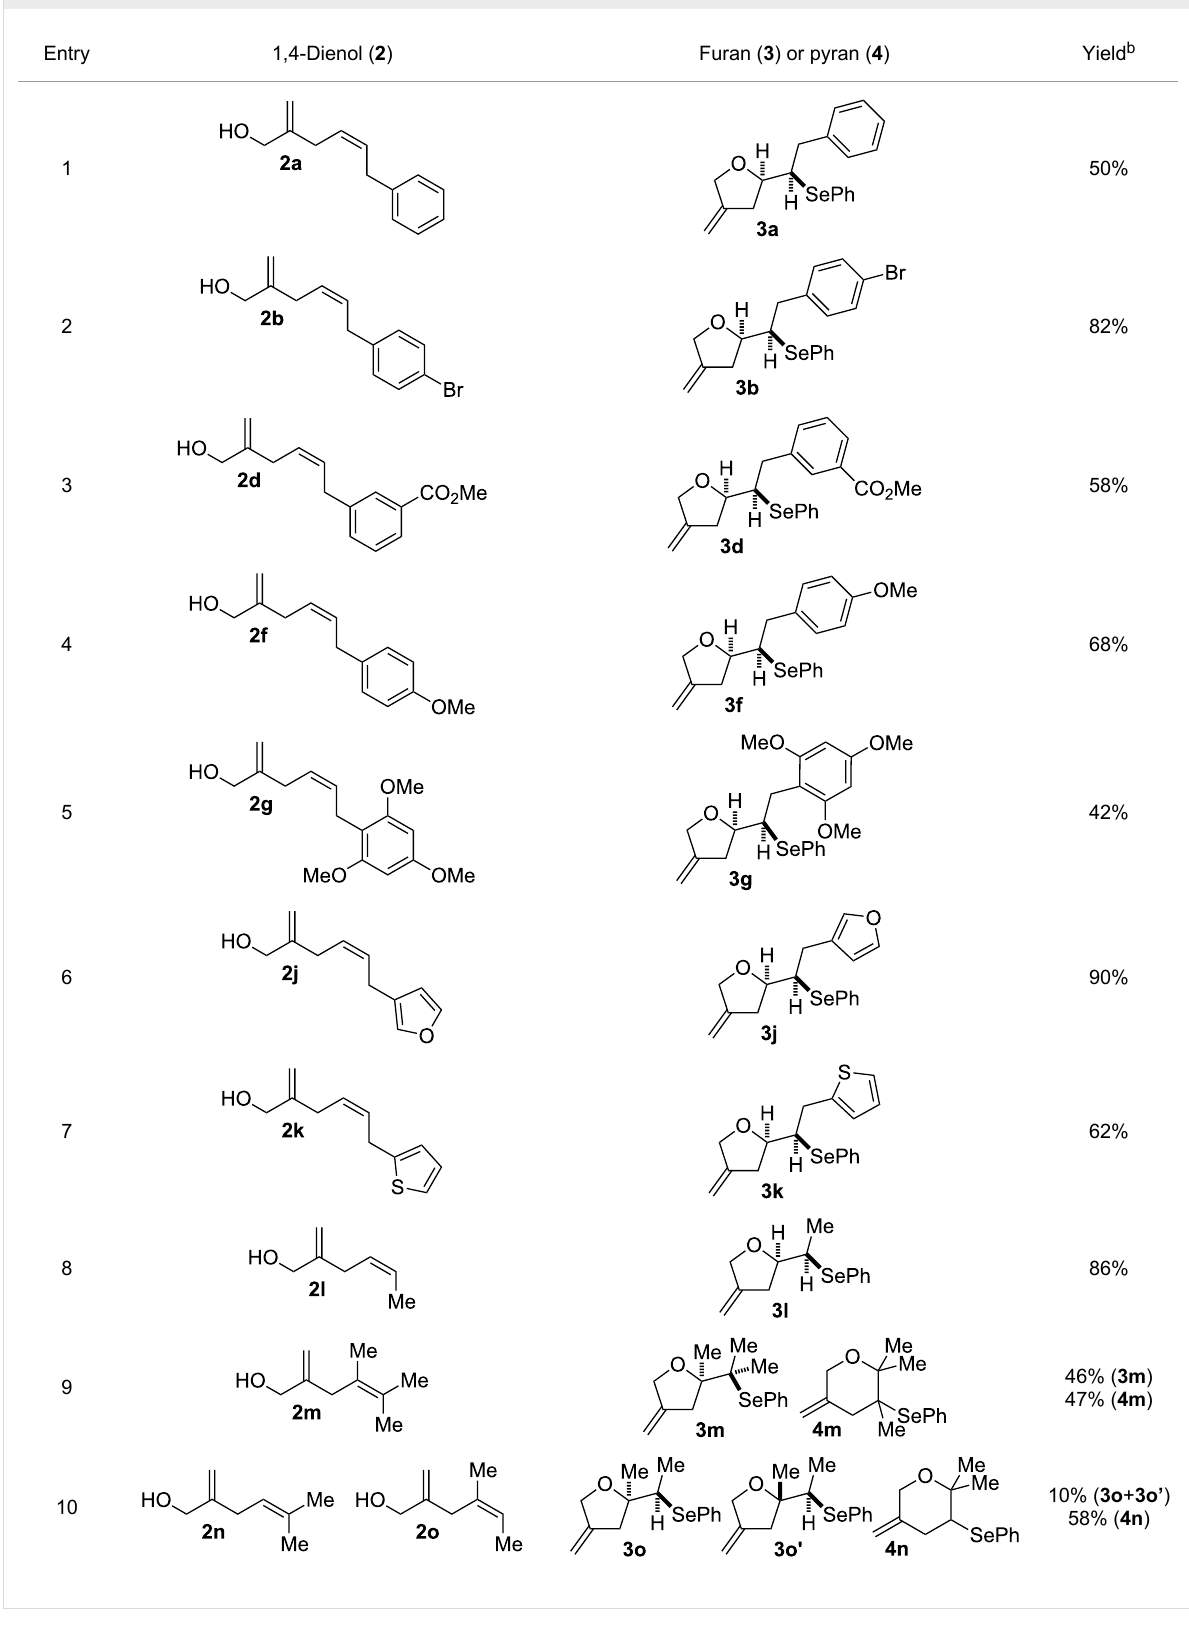
Table 2: Electrochemical selenoalkoxylation of 1,4-dienols 2 a